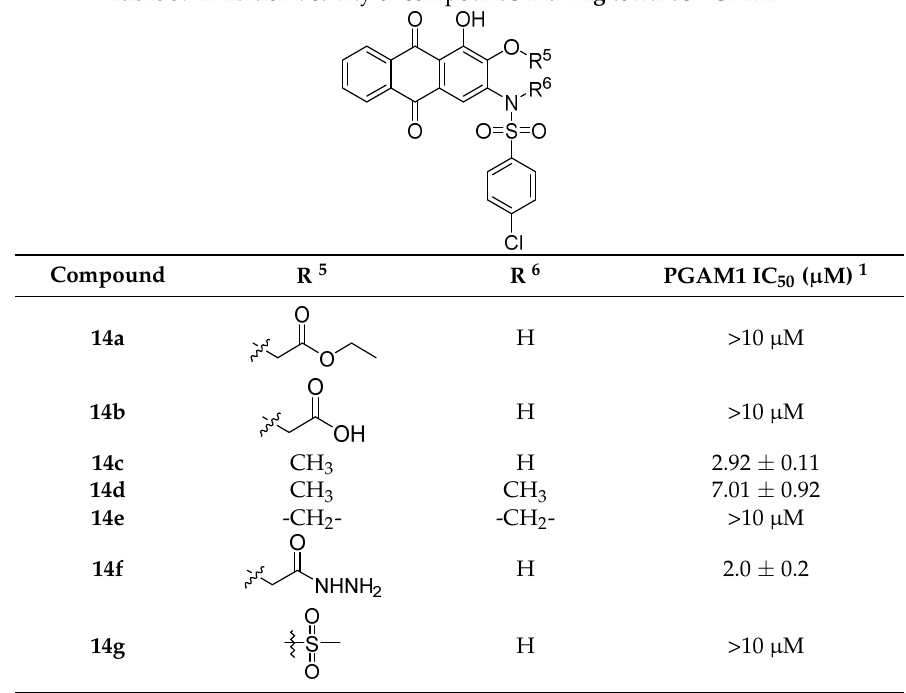
Table 4. The inhibition in the control linked enzyme assay of selected compounds. Compound